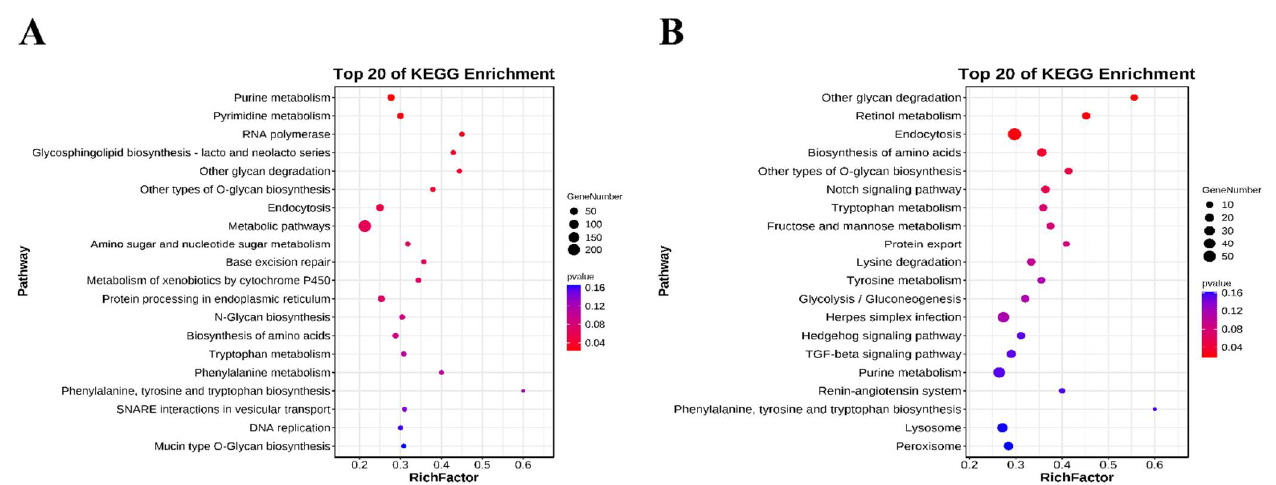
Figure 6. The top 20 KEGG pathways of predicted target genes. ( A ) The top 20 KEGG pathways in F14 vs. F20 comparison group; ( B ) the top 20 KEGG pathways in S14 vs. S20 comparison group.